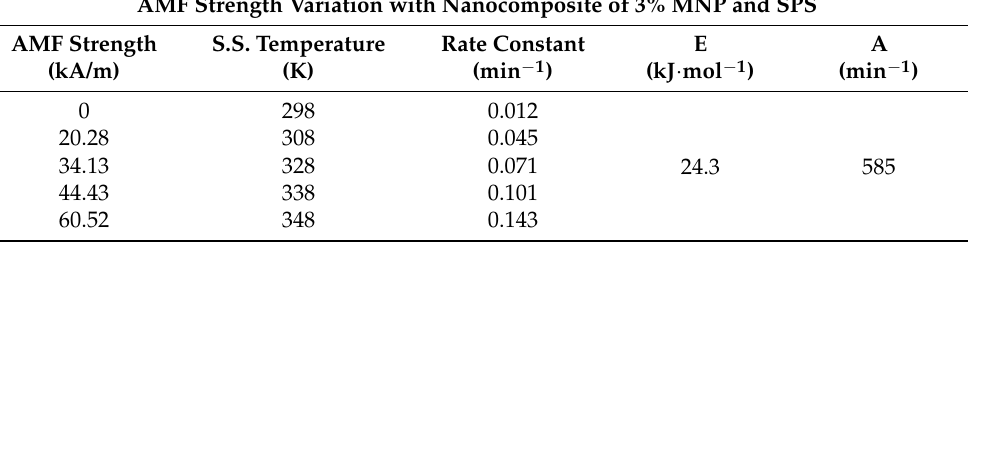
Table 1. Reaction rate constant of RhB degradation at different AMF strengths with a nanocomposite of 3% MNP and their corresponding activation energy and Arrhenius